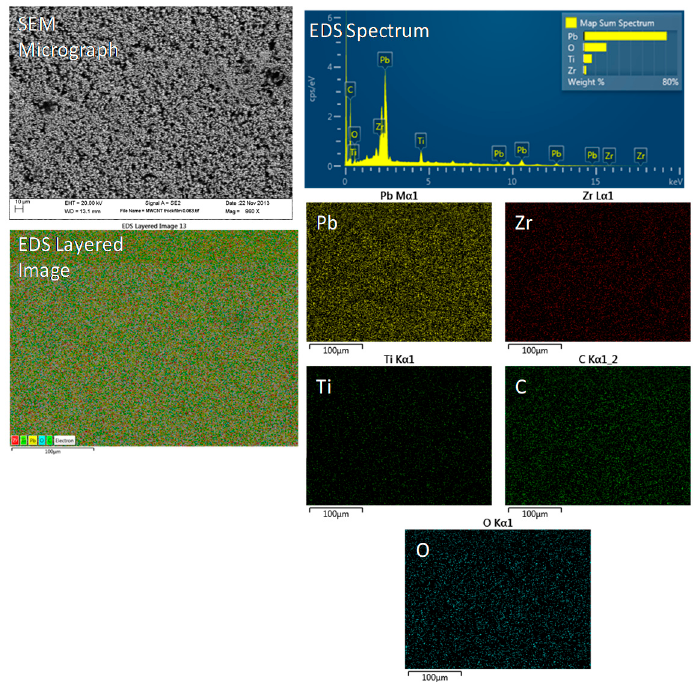
Figure 14. The SEM micrograph of the surface of the flexible composite thick film, shows the distribution of PZT particles and MWCNTs in the epoxy matrix with a MWCNT volume fraction of 0.06 (6%). The EDS layered image also shows the dispersion of the different elements present in the composite. The peaks for the selective elemental analysis are shown in the EDS spectrum.